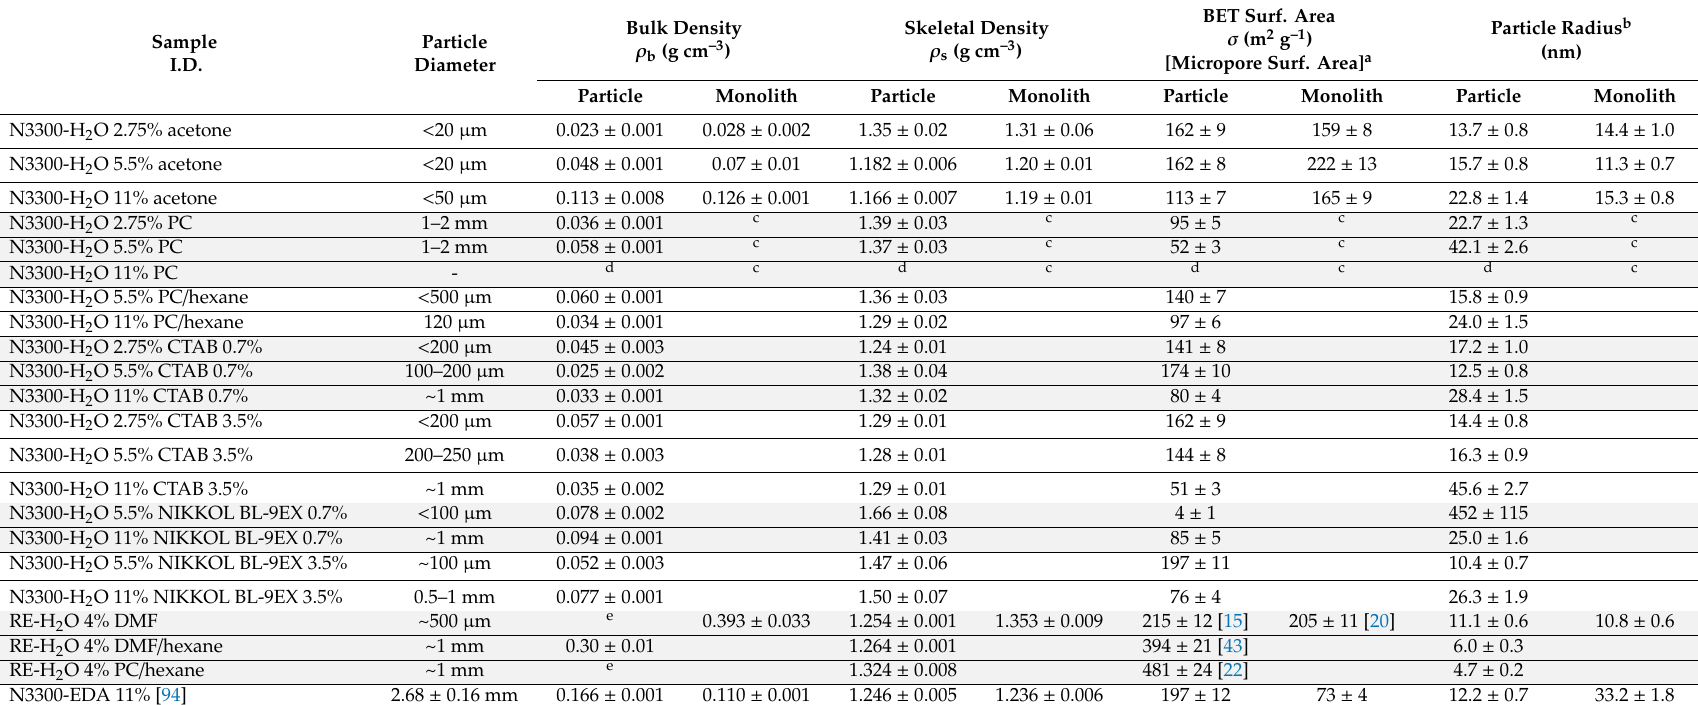
Table 1. Selected properties of particulate PUA